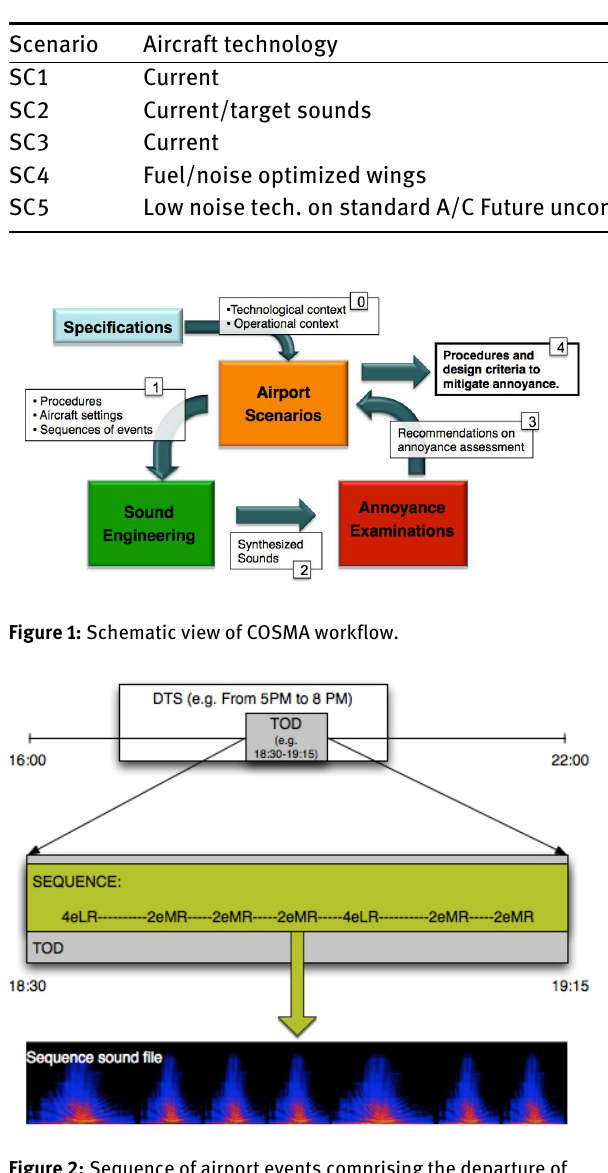
Table 2: - The five technology scenarios.